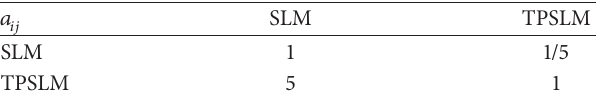
Table 9: Judgment matrix of environmental impact.